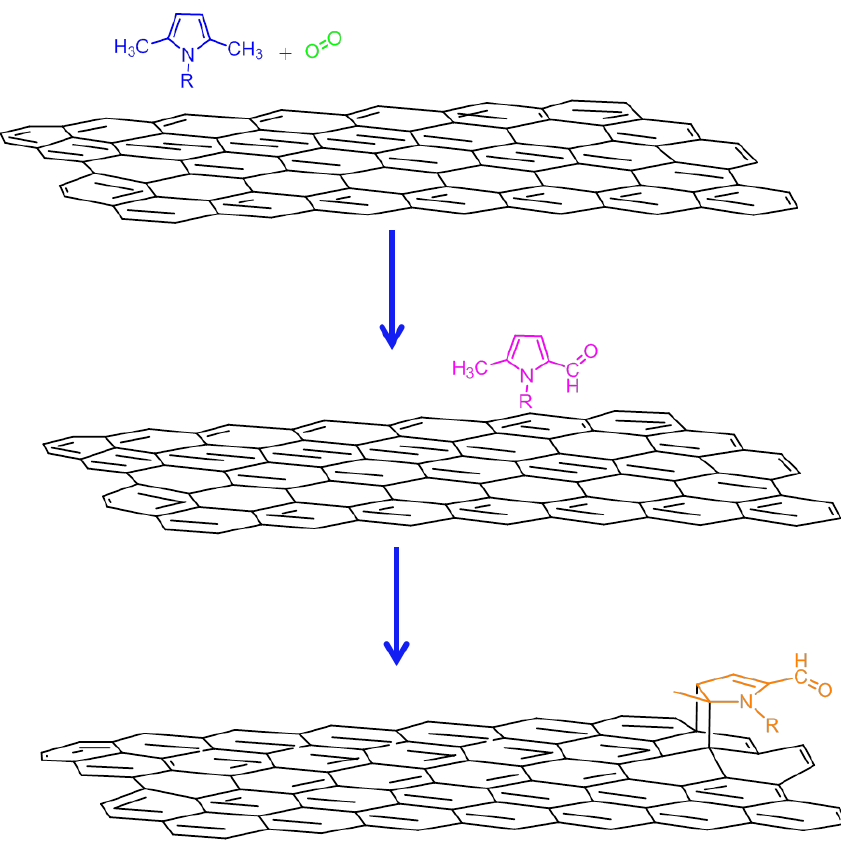
Figure 14. Hypothesized mechanism for the decoration of graphene layers with pyrrole compounds The Diels-Alder reaction [68] could in principle occur between the double bond of the pyrrole ring, activated by oxidized lateral substituent (either aldehydic or carboxylic acid groups) and the graphitic substrate. The activated pyrrole molecule would act as the dienophile and the graphene layer as the diene.